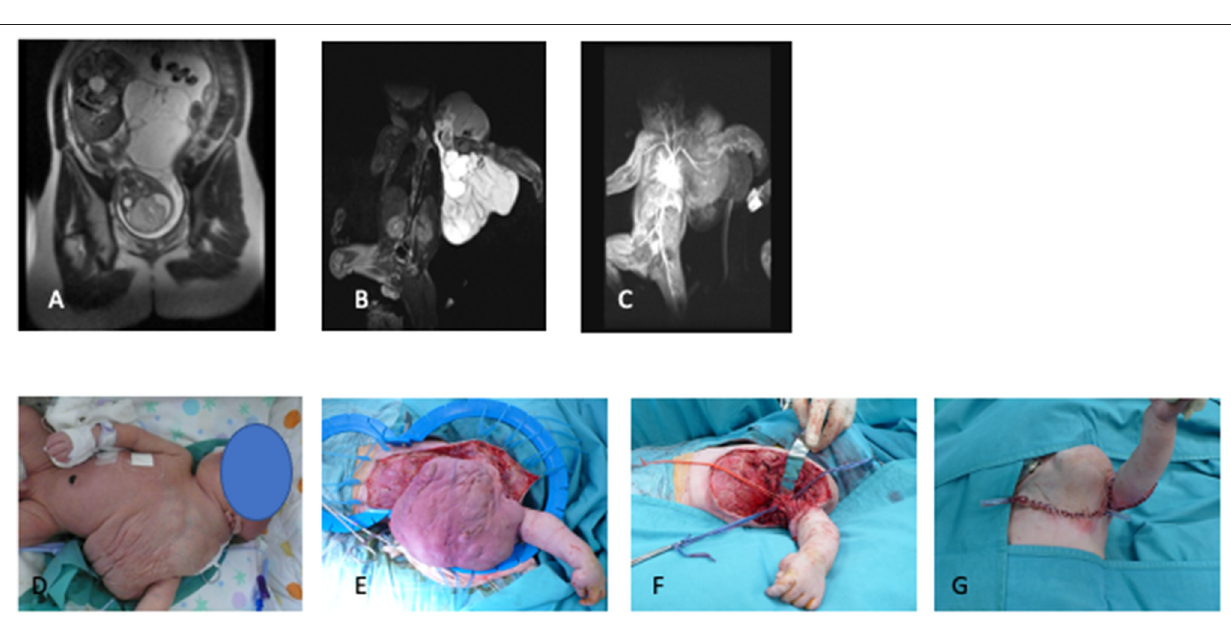
all except one patient with tongue involvement underwent a tracheostomy, vs. none of the patients with neck/mediastinal LMs without tongue involvement. This is consistent with the reported experience by Laie et al. who described 13 cases of EXIT in fetuses prenatally diagnosed with cervical LM (16). In our center, criteria to plan and perform EXIT were deviation, compression, or obstruction of the airways. Consistent